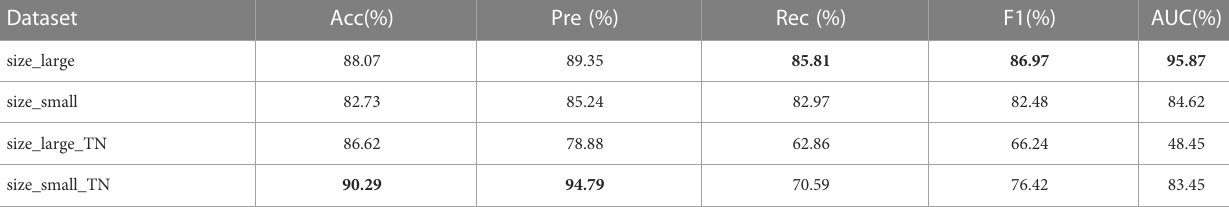
TABLE 7 Diagnostic performance of CAMBNet for differentiating molecular subtypes based on tumor size. Dataset